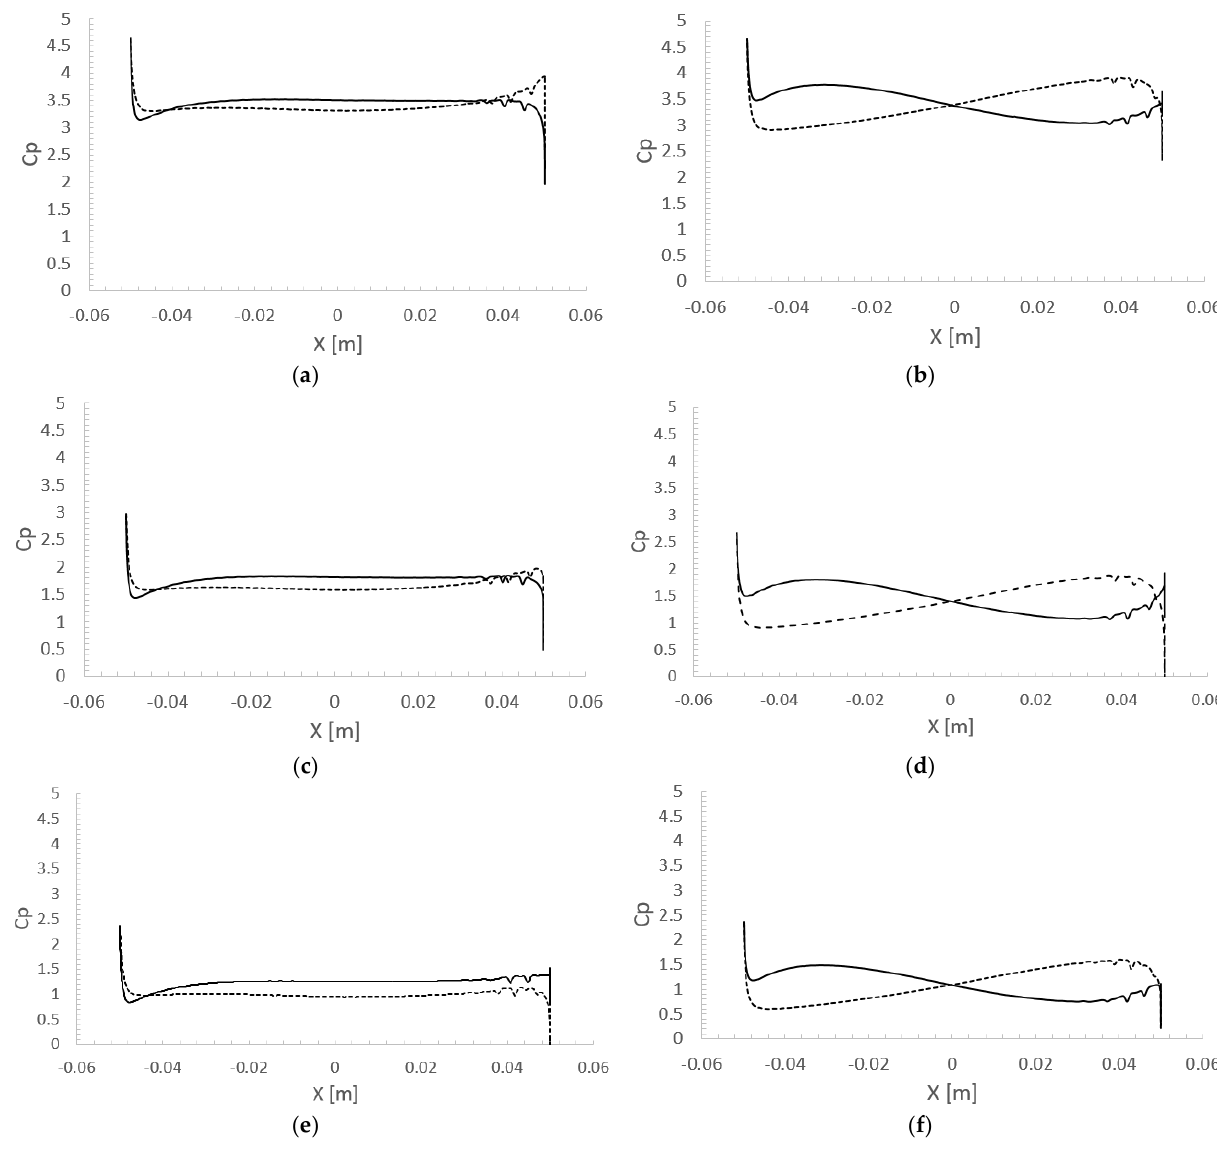
= 2 ( a , b ), σ = 0.98 ( c , d ), and σ = 0.69 ( e , f ) regimes at t / T = 0 σ i σ i σ i 𝜎𝜎 = 0 ( a , c , e ) and t/T = 0.25 ( b , d , f ).